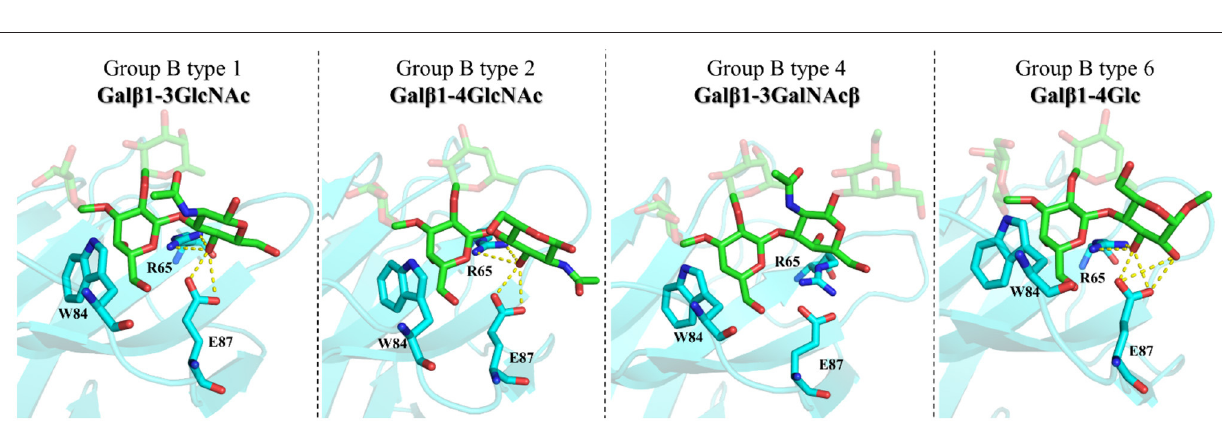
FIGURE 8 | Molecular models of the complexes between Gal-4N and group B types-1, -2, -4, and -6 antigens according to MD simulations. Key residues are